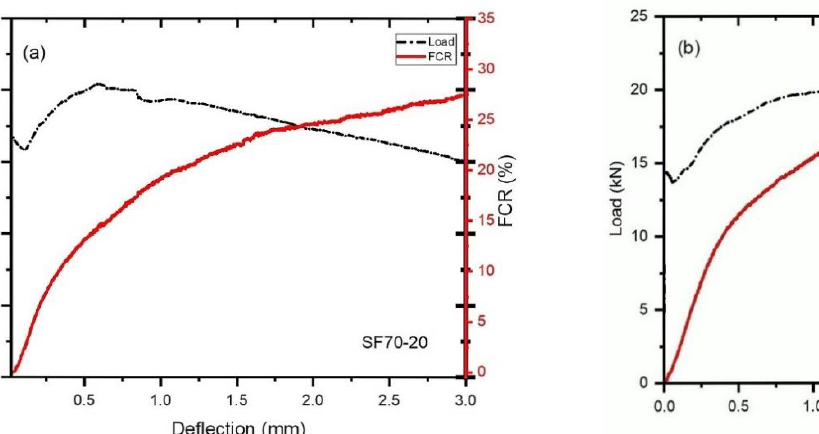
Figure 4. Load-deflection-FCR curves of 5 – 10 mm coarse aggregates ( a ) SF70-10 ( b ) SF70-CB4-10 ( c ) SF70-PP2-10 ( d ) SF70- PP2-CB4-10.